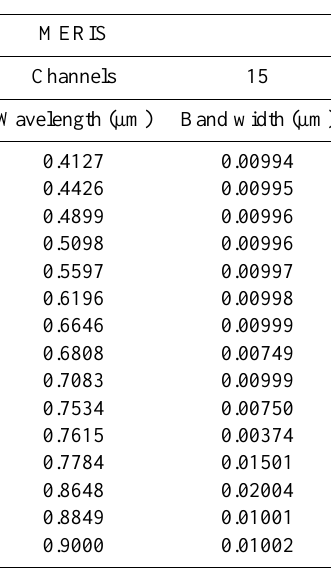
Table 1. Spectral channels of MERIS and SeaWIFS.